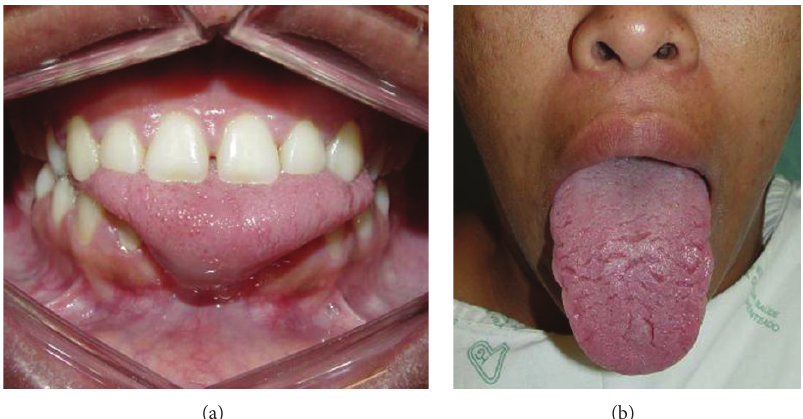
Figure 1: The tongue was increased both in length and in width, with anterior open bite with interposition of the tongue and loss of 31 and 41 teeth.